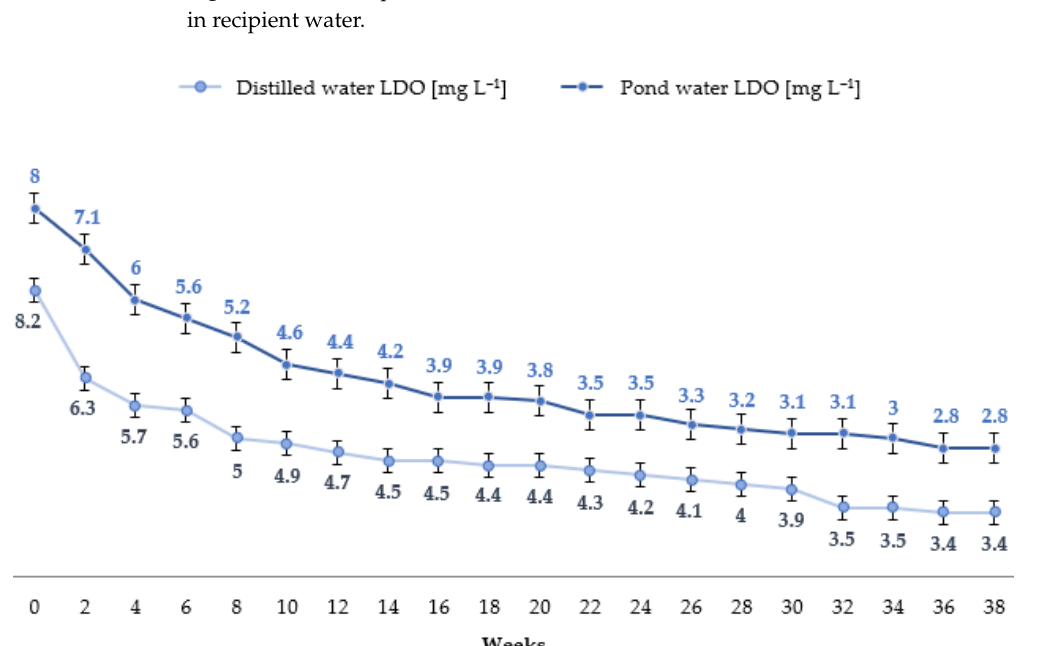
Figure 6. LDO values (mg L − 1 ) measured in the leachates of tire fractions in distilled water and in recipient water.